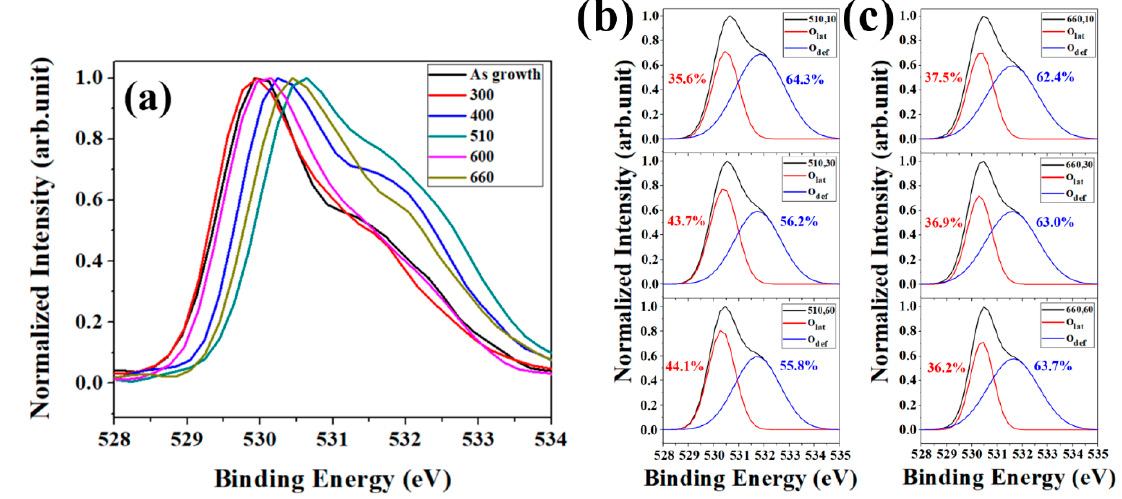
Figure 3. ( a ) O1s XPS for varied annealing temperature with the time of 10 s. ( b ) O1s XPS for the annealing temperature of 510 ◦ C with varied time. ( c ) O1s XPS for the annealing temperature of 660 ◦ C with varied time.